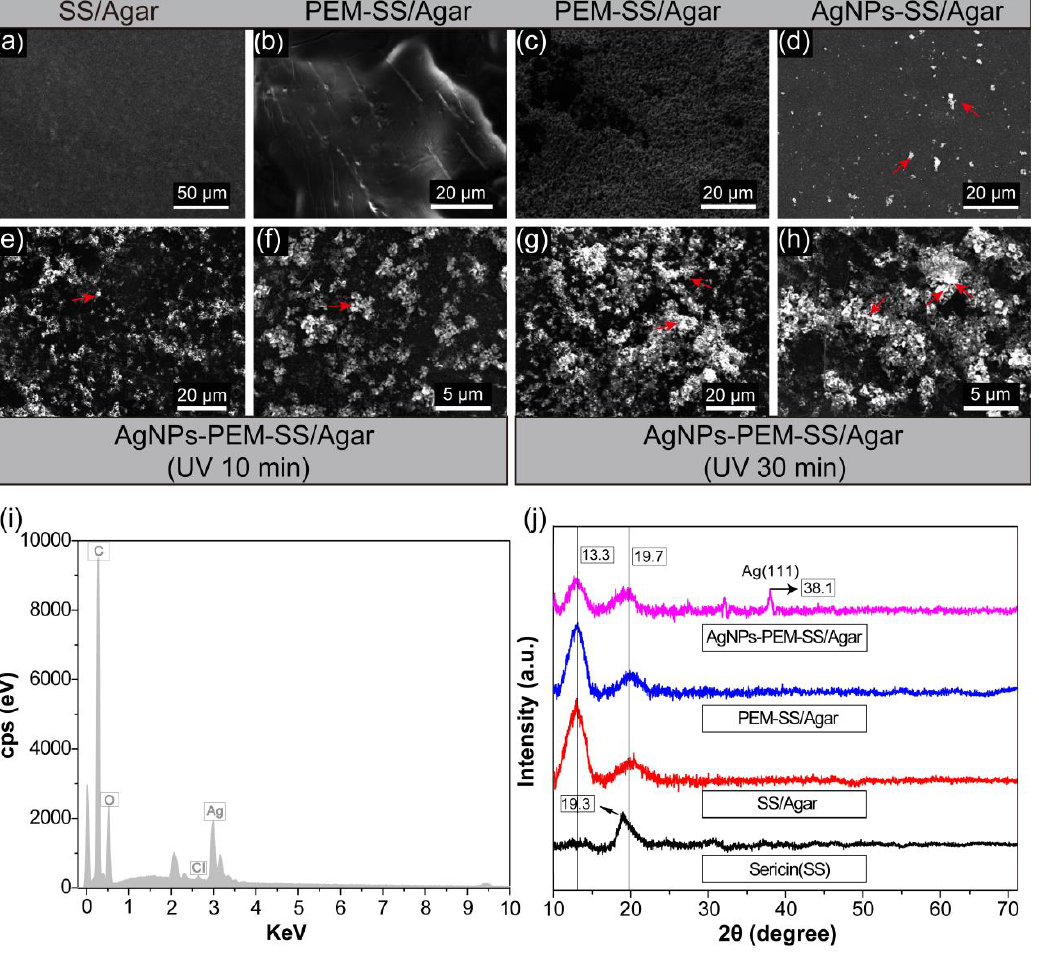
Figure 2. Surface morphologies of SS/Agar ( a ); PEM ‐ SS/Agar ( b ); cross-section of PEM ‐ SS/Agar films ( c ); AgNPs ‐ SS/Agar film (10 min irradiation) ( d ); AgNPs ‐ PEM ‐ SS/Agar film (10 min ( e , f ) and 30 min ( g , h ) irradiation), ( f , h ) are the high magnification of ( e , g ), respectively; EDS spectrum of AgNPs ‐ PEM ‐ SS/Agar film ( i ); XRD patterns of different films ( j ).